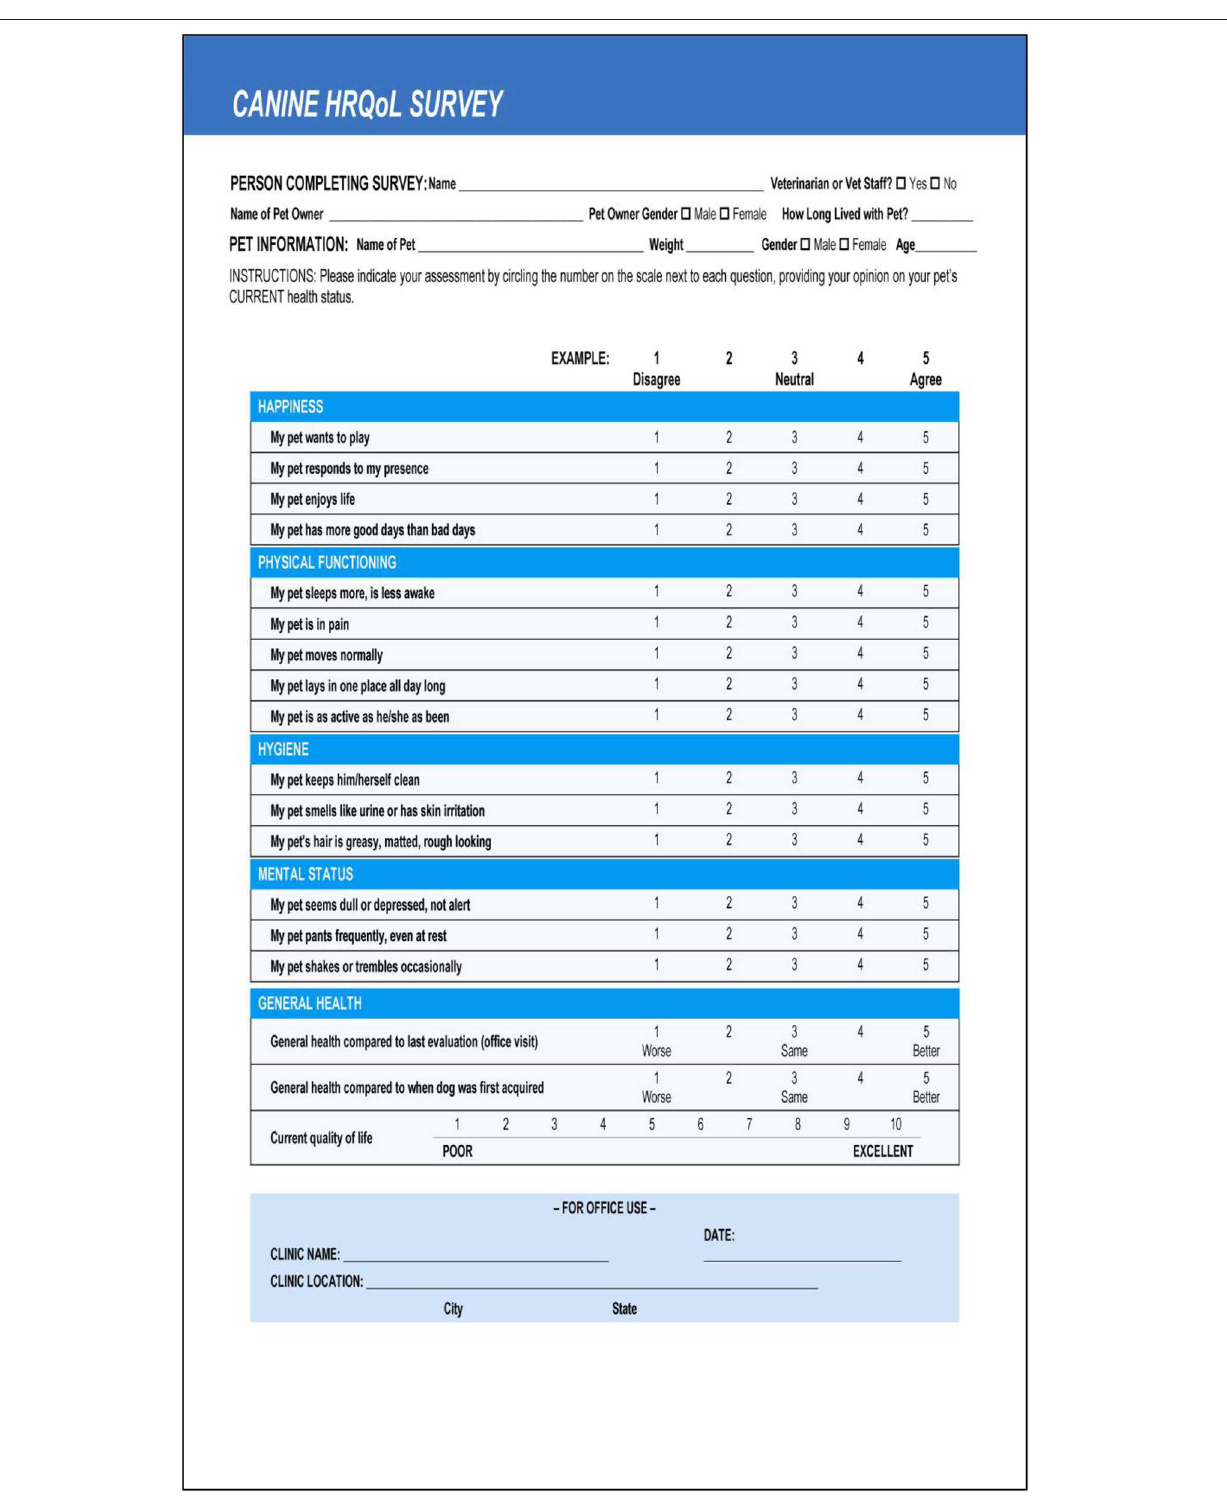
Frontiers in Veterinary Science |